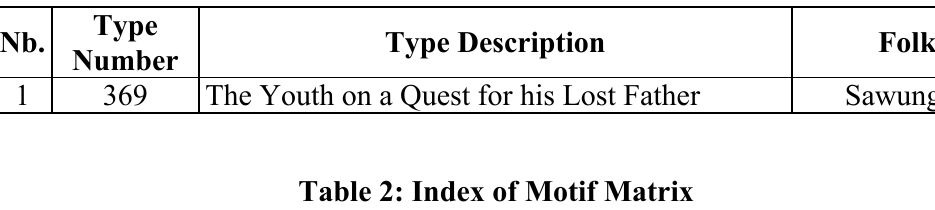
Table 1: Index of Type Matrix